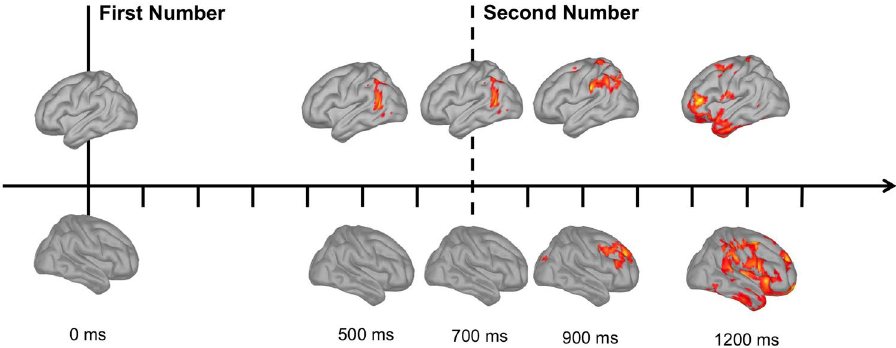
Figure 2. Results of cluster-based permutation analysis. The figure shows a schematic representation of the results of cluster-based permutation analysis, comparing Fast Responses and Slow Responses ( Fast > Slow ). Colors highlight the areas in which the significant effects were mostly localized. In all cases, Fast Responses were associated with higher values (z-scores) compared to Slow Responses . The solid vertical line indicates the appearance of the First Number , whereas the vertical dashed line indicates the appearance of the Second Number . Differences were initially found in the left hemisphere (mostly in the Angular Gyrus), starting at about 500 ms after the First Number and lasting also after the second stimulus. Within the right hemisphere, significant differences were found about 200 ms after the presentation of the Second Number in the right frontal cortex, followed by a more widespread effect starting at encompassing also the right parietal cortex. The figure was drawn by the first author of the paper—Giorgio Arcara.